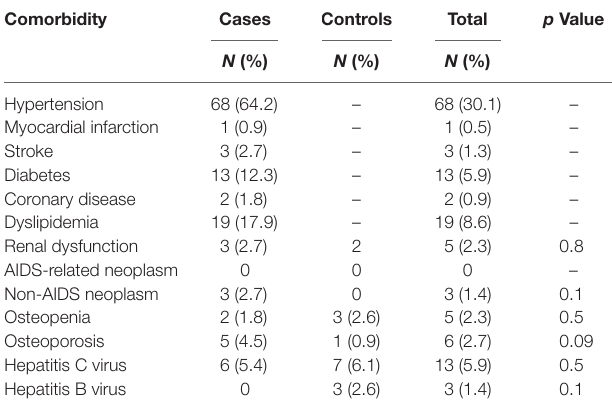
TaBle 2 | Frequency of diagnosed cardiovascular diseases, coinfections, and other comorbidities in cases and